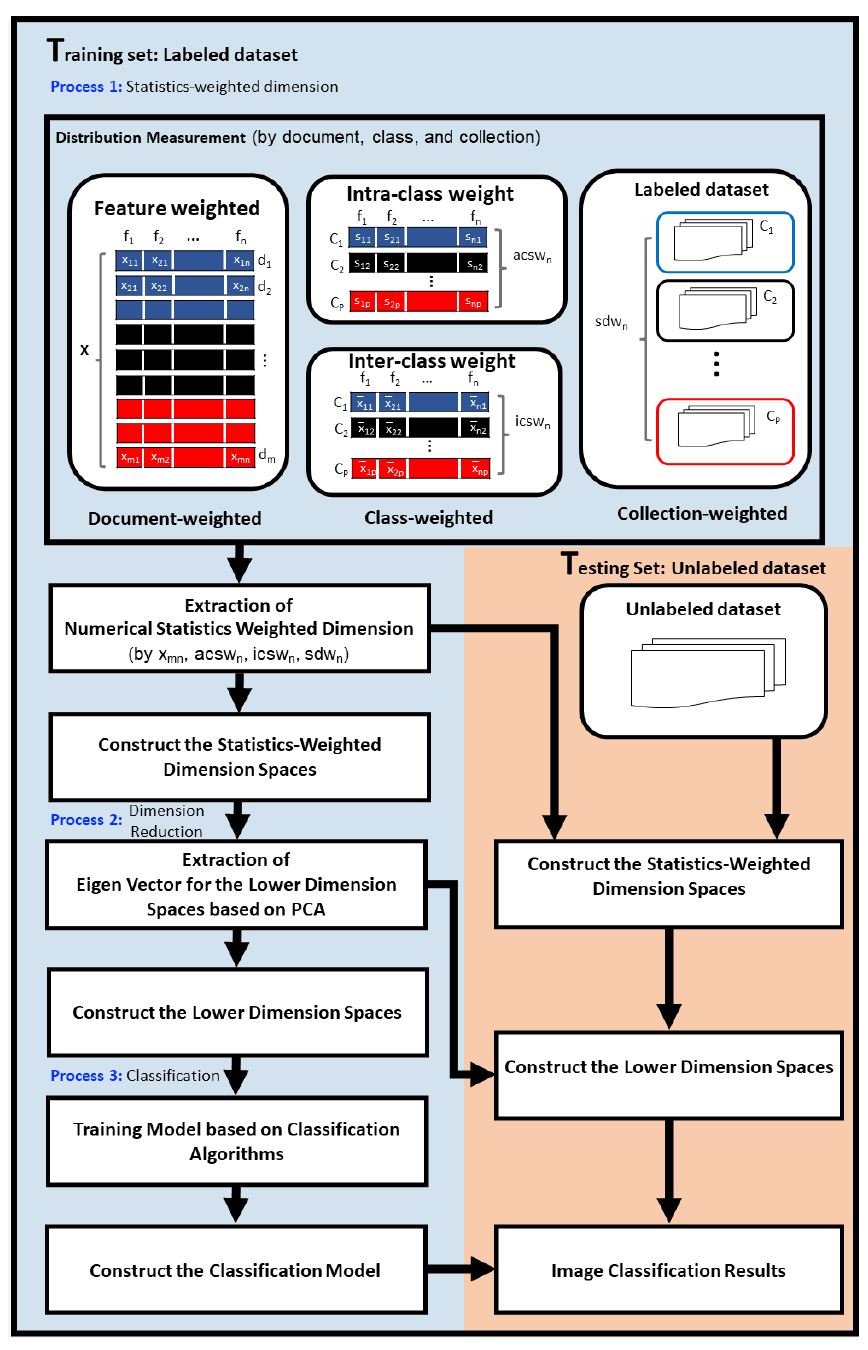
Figure 1. The complete framework of improving classification performance with statistically weighted dimension and dimensionality